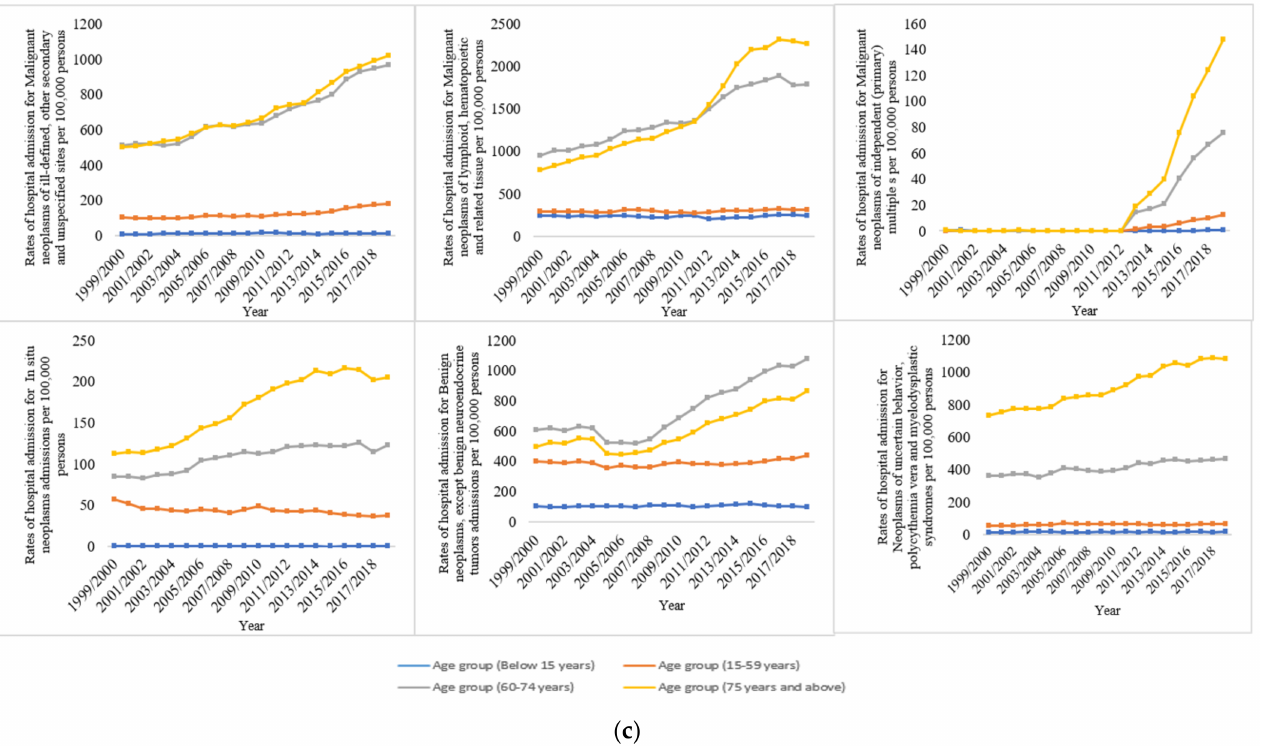
Figure 4. ( a ) Hospital admission rates for neoplasms in England and Wales stratified by age group be- tween 1999 and 2019; ( b ) Hospital admission rates for neoplasms stratified by age group (continued); ( c ) Hospital admission rates for neoplasms stratified by age group